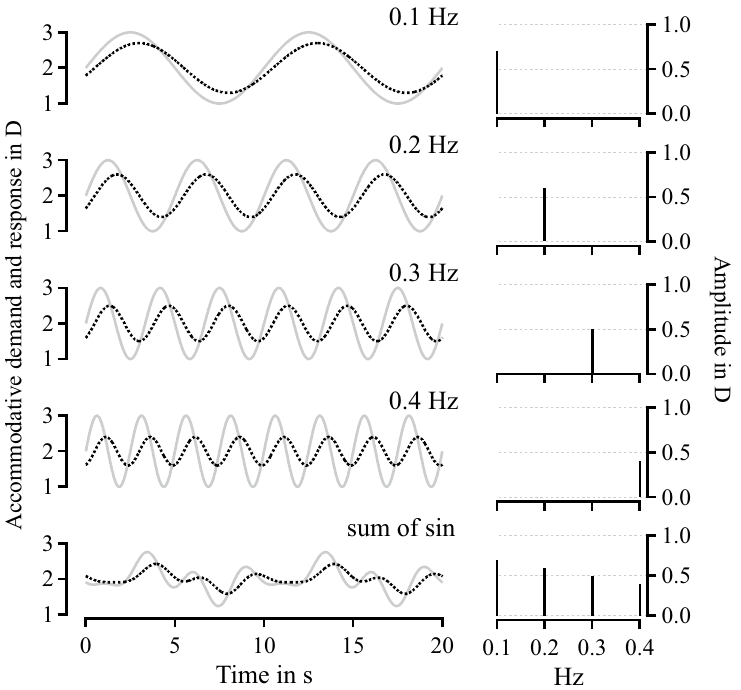
Figure 1. Dynamic accommodation stimulus profiles. The first four rows of the left column show examples of typical and highly predictable sinusoidal accommodative demand profiles (gray curves) at different temporal frequencies and a noiseless accommodative response (solid dotted curve). The last row show an atypical, non- predictable motion profile generated as the sum of the previous four sines and a random phase as those used by Kruger et al. 15 The graphs on the right column show the amplitude spectra obtained with Fourier analysis of the noiseless response. The amplitude and phase of the accommodative response in these illustrative examples were chosen as they are typical of these types of experiences. For an observer, amplitude tends to decrease and phase tend to increase for faster moving